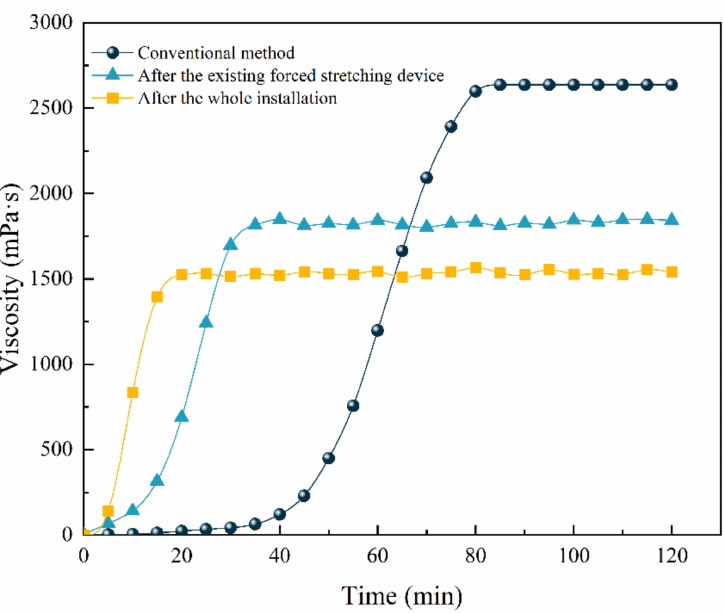
Figure 14. Polymer AP-P4 dissolution time after forced stretching + super gravity fast dissolution